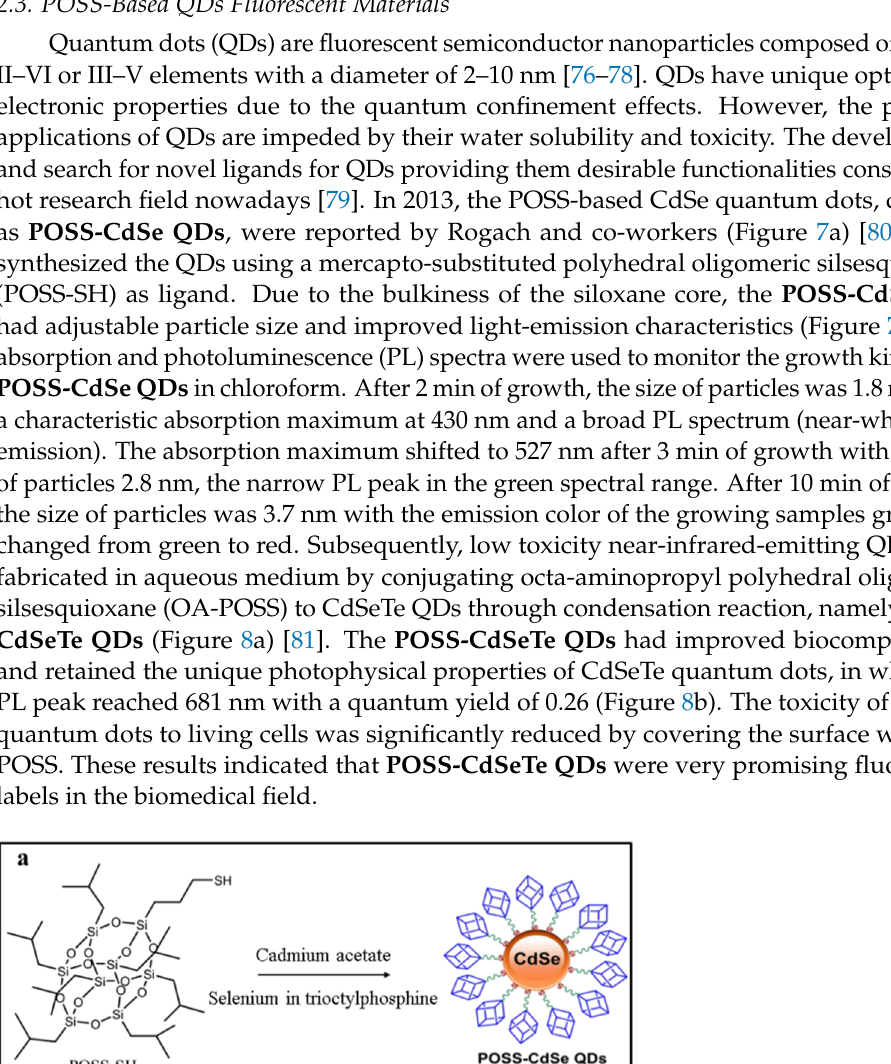
Figure 8. ( a ) Synthetic procedure of POSS-CdSeTe QDs [81]. ( b ) The PL spectra and cytotoxicity of SiHa cells incubated with different concentrations of POSS-CdSeTe QDs and CdSeTe QDs [81]. Graphene quantum dots (GQDs) [82], as nanometer-sized graphene derivatives with low toxicity, low-cost processing, and unique PL properties, provide new possibil- ity to replace the aforementioned QDs due to their high PL stability. However, the strong π – π stacking interactions induce the aggregation-caused PL quenching (ACQ) in the solid state, which greatly limits their application. Recently, Jeon and co-workers demonstrated for the first time that surface functionalization of QDs (F-GQDs) by POSS, poly(ethylene glycol) (PEG), and hexadecylamine (HDA) could effectively reduce ACQ (Figure 9) [83]. The surface functionalization was achieved by the carbodiimide coupling chemistry between the primary amine of POSS, PEG, and HDA with the carboxyl groups on the edge of the GQDs. In solutions, the photophysical properties of F-GQDs were similar to those of bare GQDs with the absorption peak at less than 300 nm and PL peak at about 400 nm. While the POSS-GQDs, PEG-GQDs, and HDA-GQDs showed a significant enhancement in PL intensity compared to bare GQDs by 9.5-, 9.0-, and 5.6-fold in spin-coated film form and by 8.3-, 7.2-, and 3.4-fold in drop-casted film form, respectively. The results indicated that the POSS was an excellent functionalizing rea- gent for GQDs.